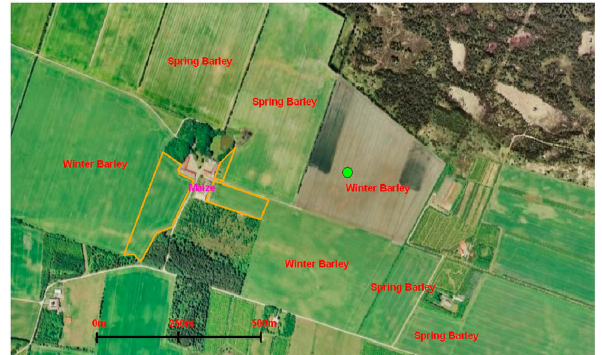
Fig. 1. Orthophoto showing the heterogeneity of the Voulund (VOU) field site. The labelled crop types were grown in 2009 and the green point indicates the location of the flux tower. Figure taken from Ringgaard et al.